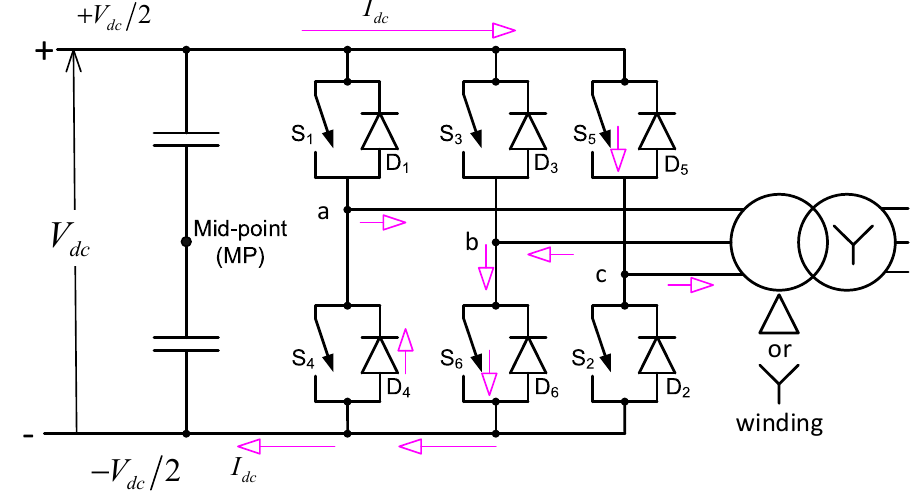
Figure 14. Basic three-phase Voltage Source Converter.